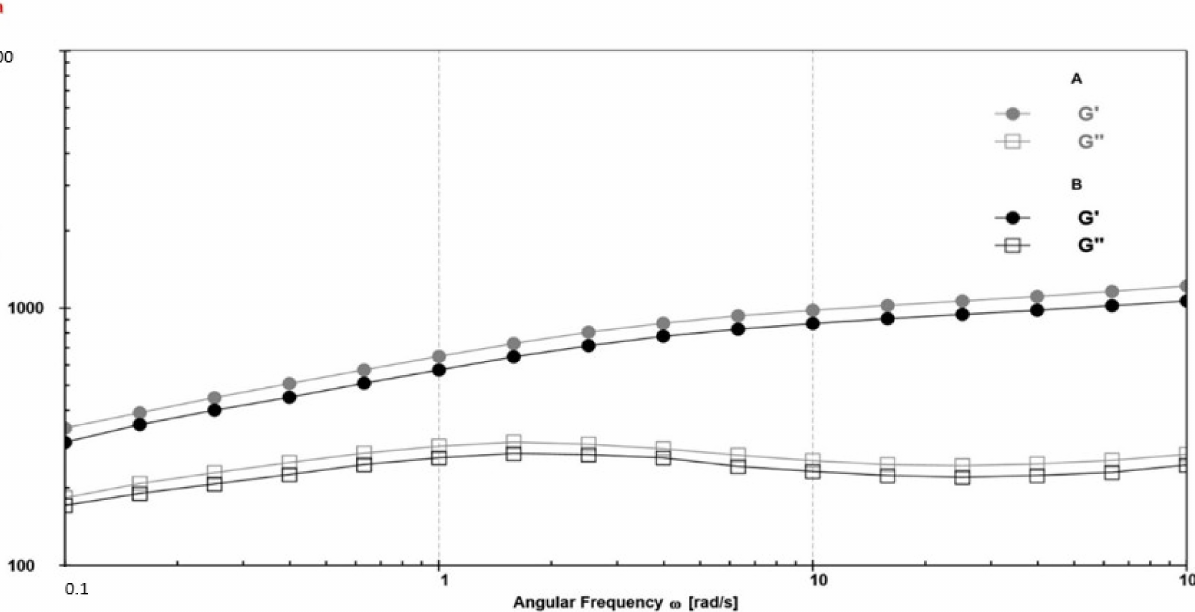
Figure 5. Viscoelastic characterization of A and B represented plotting the storage modulus G (cid:48) and loss modulus G (cid:48)(cid:48) as a function against complex strain, at constant angular frequency. The curves deriving from the frequency sweep test were realized by interpolating G (cid:48) and G (cid:48)(cid:48) (Figure 6a) or the complex viscosity ( η *; Figure 6b) with angular frequency, at a fixed strain, within LVR. A and B can be considered stable emulsions owning G (cid:48) > G (cid:48)(cid:48) over the entire measured frequency range (Figure 6a). Moreover, the absence of a crossover in Figure 6a suggested that each emulsion can be considered as non-sticky [46,47]. A linear reduction in log η * was observed (Figure 6b), confirming the gel-like structure and viscoelastic solid behavior. The same profile was observed for A and B stored at different temperatures for up to 6 months (data not shown), predicting the long-term stability [51]. The presence of CSE did not interfere with the intrinsic structure of the formulation, maintaining B an elastic structure over the range of frequency (Figure 6b, black